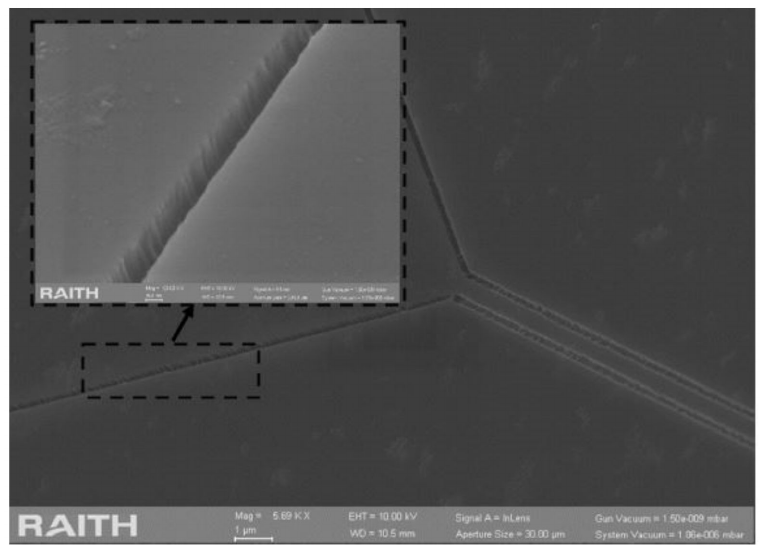
Figure 20. Etching result after RIE using the negative resist